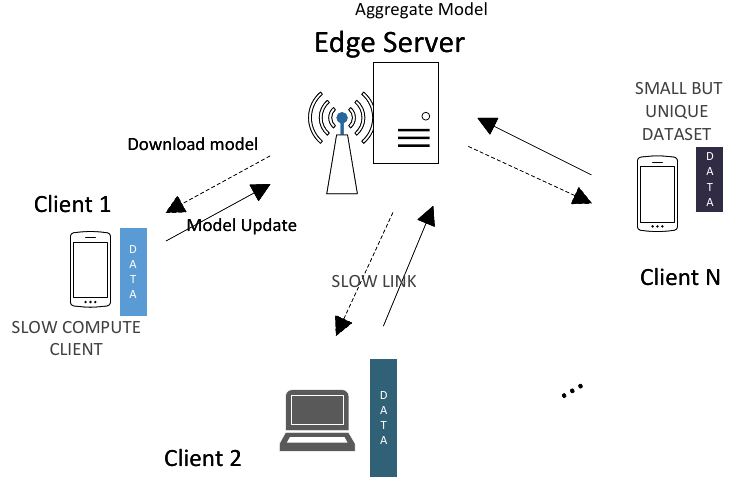
Figure 1. System model for federated learning over wireless edge